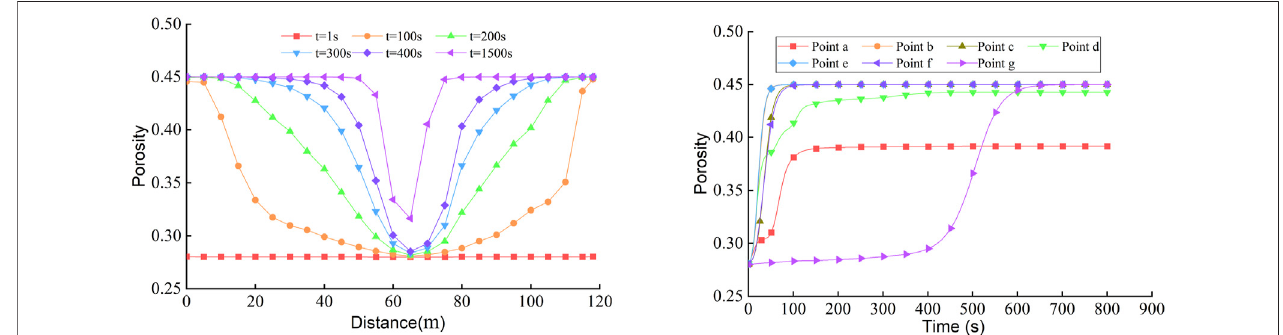
FIGURE 13 | Porosity evolution at measuring line and typical